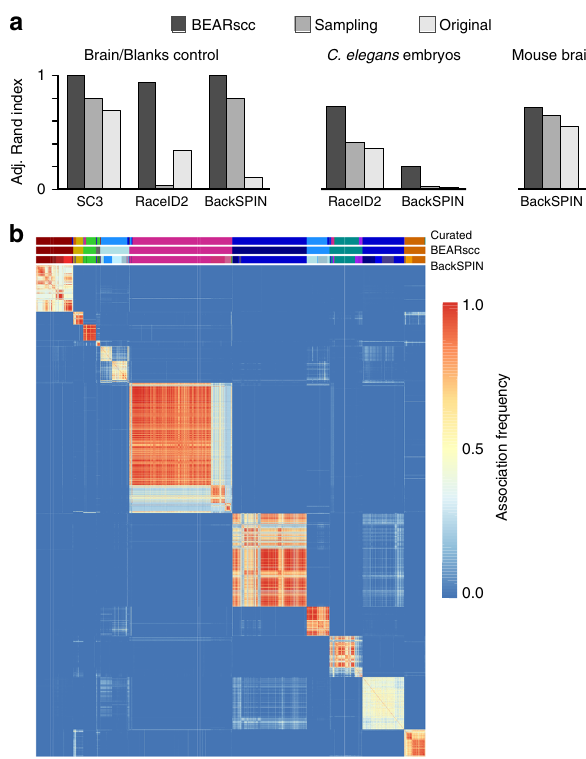
Fig. 2 BEARscc improves clustering results and aids the interpretation of biological results. a Comparison of clustering accuracy of control data (left), C . elegans data (middle), and murine brain data (right). Adjusted Rand index denotes agreement with the manually annotated grouping of samples (1: perfect, 0: no overlap). ‘ BEARscc ’ indicates that BEARscc was used to generate simulated technical replicates that were clustered using the algorithm indicated below the graph; ‘ Sampling ’ indicates that a sub- sampling approach (see text) was used before clustering with each algorithm; ‘ Original ’ indicates that the clustering algorithm was used alone. b Example of a noise consensus matrix produced by BEARscc on data from murine brain cells (from Zeisel et al. 11 ) clustered with BackSPIN. Bars above heatmap show the manually curated clustering of cells (top), BEARscc consensus cluster (middle) and unsupervised BackSPIN clusters Fig. 3b, coloured bars above matrix); the libraries for these three samples contained fewer than 1000 observed transcripts, indi- cating that BEARscc is limited by RaceID2 ’ s oversensitivity to library size differences.